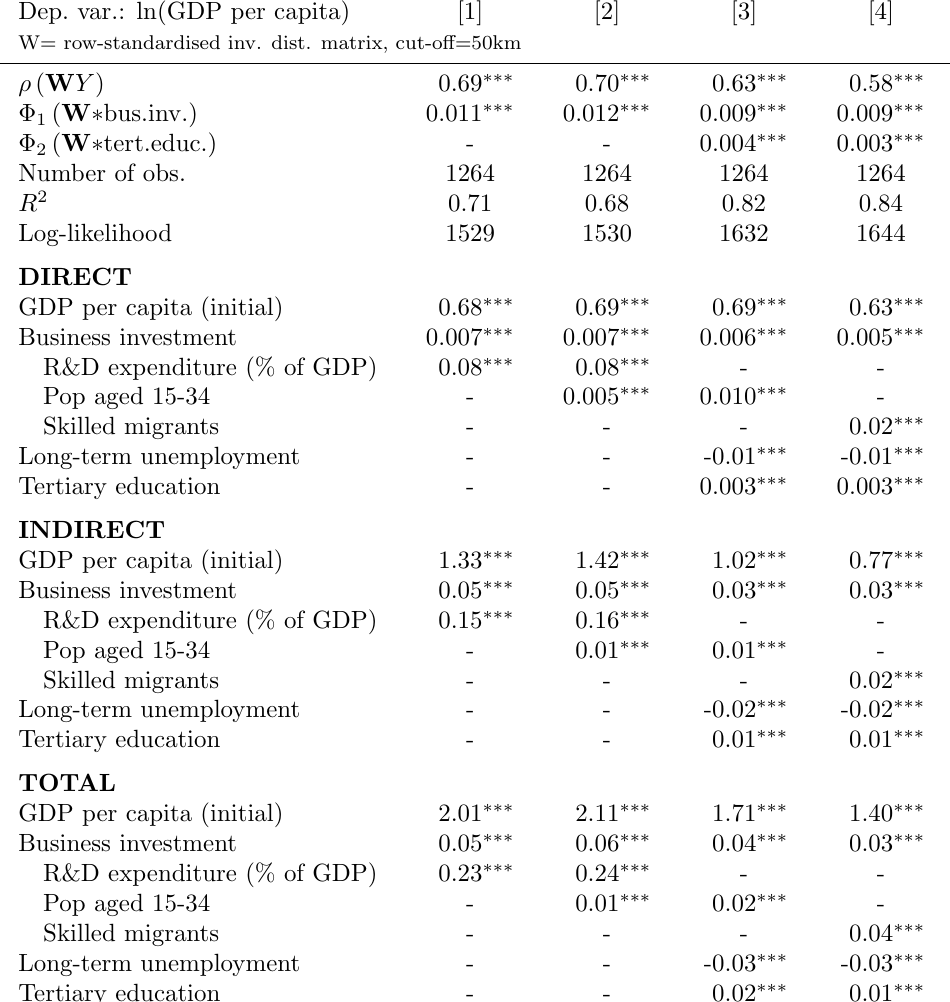
Table A.4: Empirical Results – Random effect – Euro area sample without country